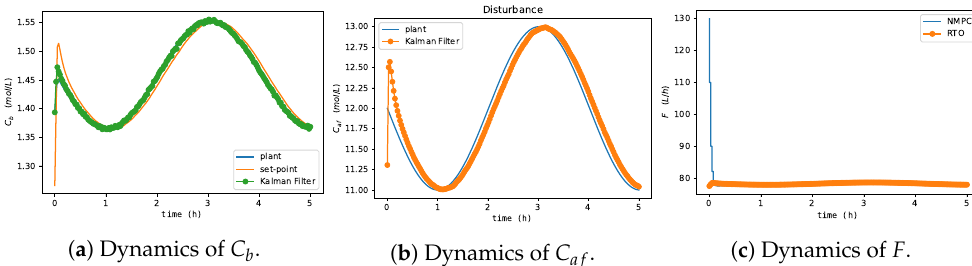
Figure 16. Dynamics of control actions ( ∆ F ) when subjected to process disturbances of Figure 14 over a 5 h control experiment, to maximize C b .